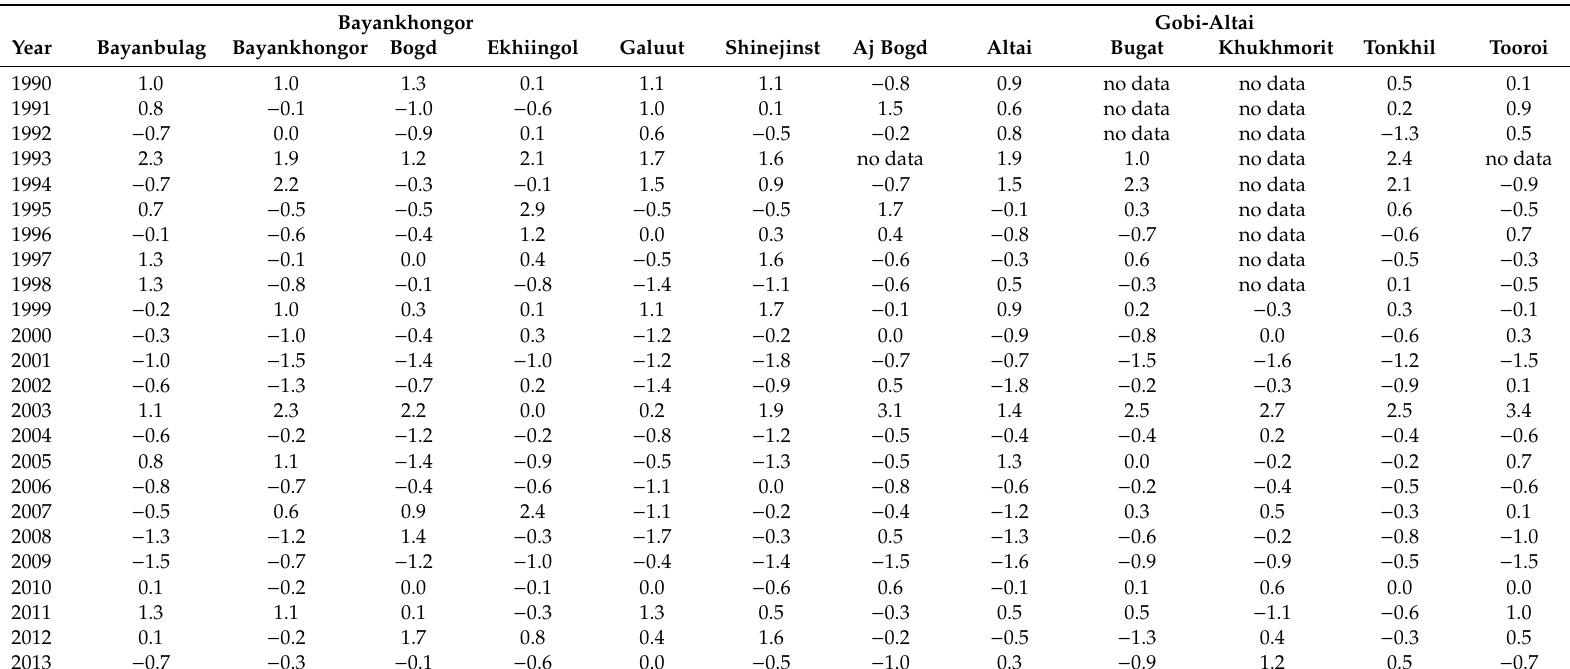
Table 3. Summary of standardized aridity index ( a AI z ) values applied for drought risk analysis in this